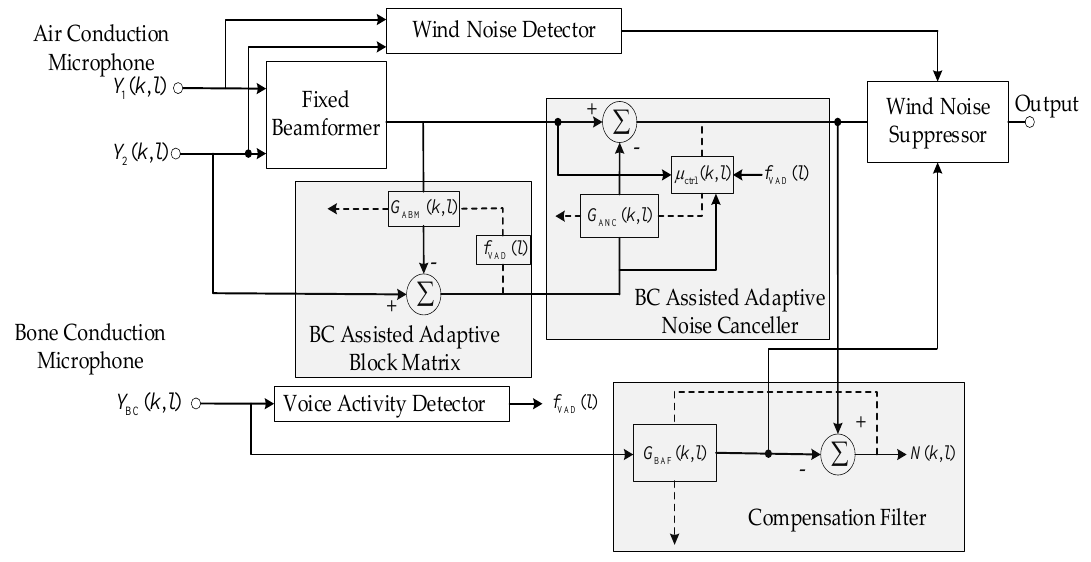
Figure 3. The robust generalized sidelobe canceller (GSC) with coefficients constrained ABM structure.